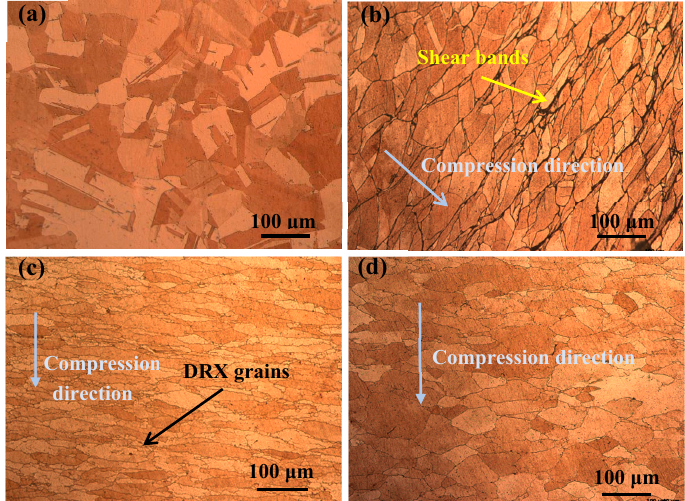
Figure 1. Optical images of the Cu-Ni-Co-Si-Cr alloy microstructure deformed under different conditions: ( a ) solid-solution; ( b ) 500 °C and 0.01 s − 1 ; ( c ) 700 °C and 0.01 s − 1 ; and ( d ) 900 °C and 0.01 s − 1 .